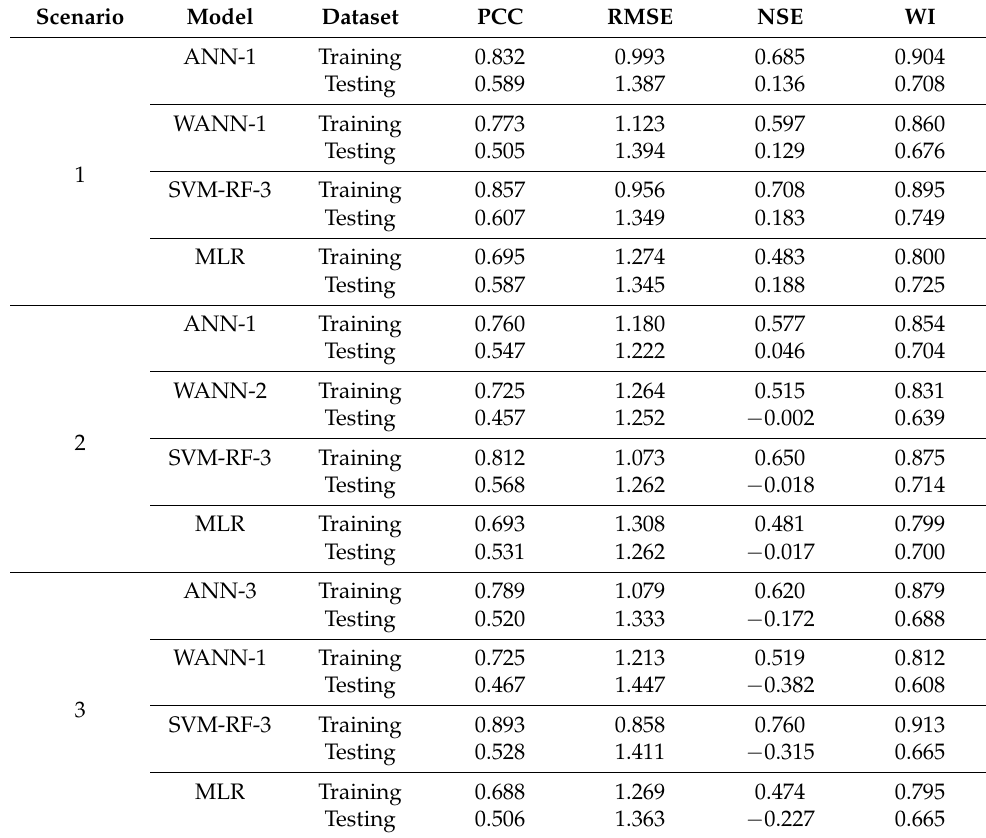
Table 7. Results for best ANN, WANN, SVM-RF, and MLR during the training and testing period for all